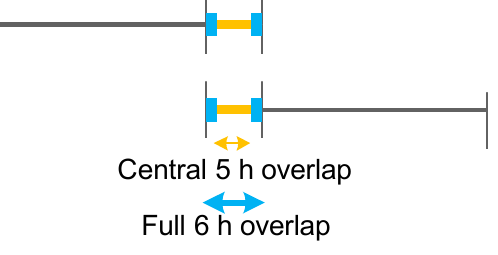
Figure 9. Orbit overlap of CSES POD.